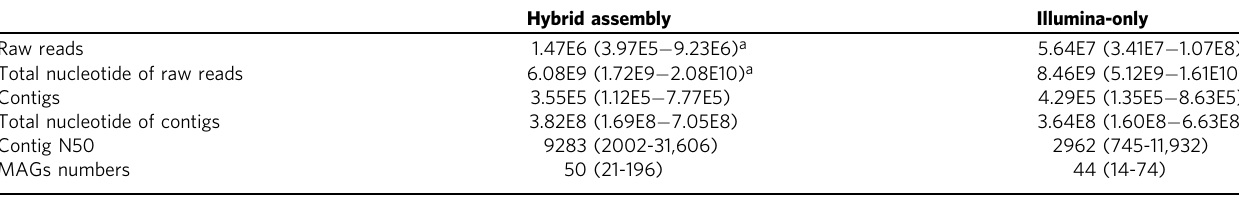
For each parameter, the average value and range are shown. a Denotes the number for ONT reads used in hybrid